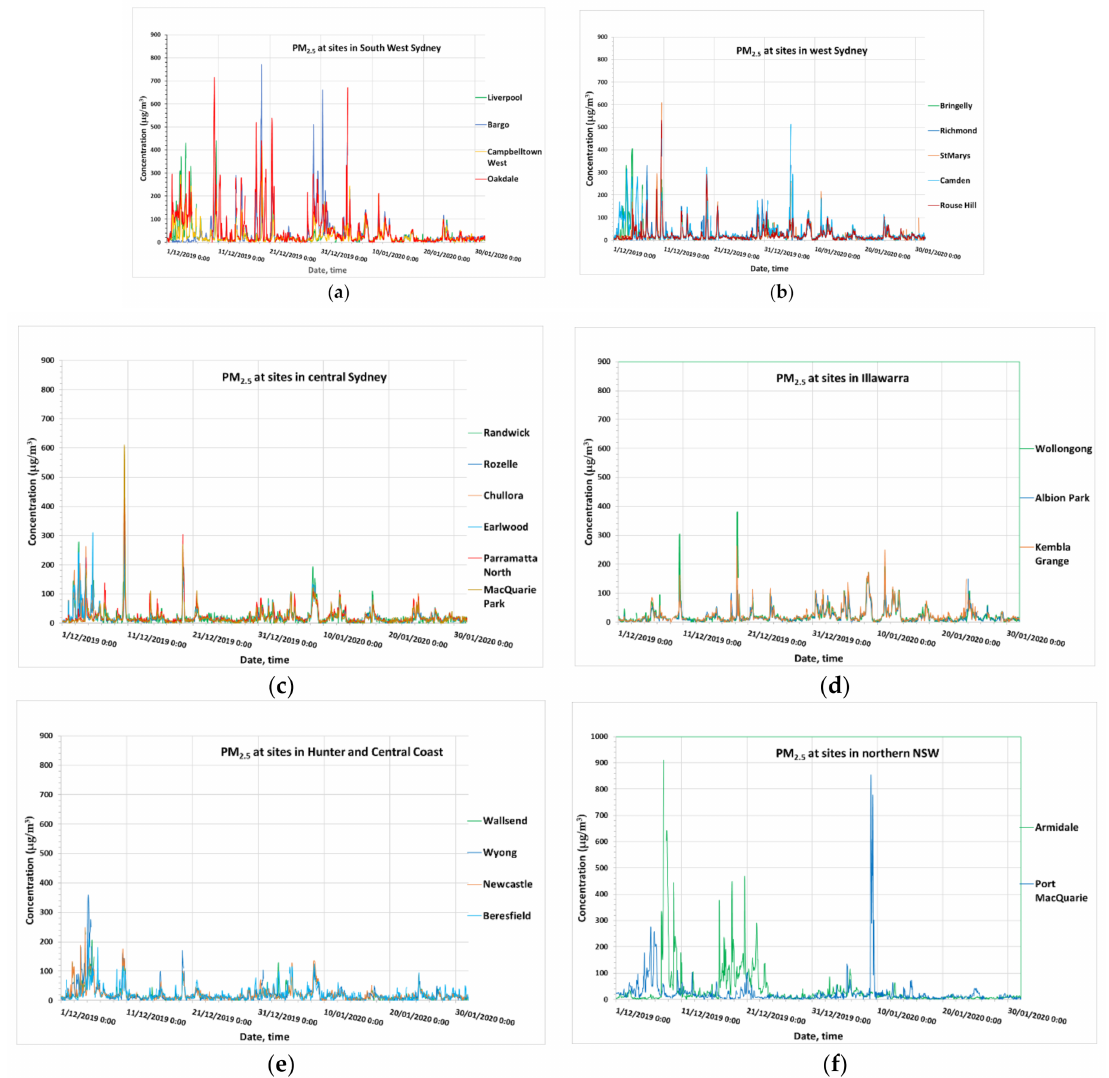
Figure 9. PM 2.5 concentration at sites in South West Sydney ( a ), west Sydney ( b ), central Sydney ( c ), Illawarra ( d ), Hunter ( e ) and northern NSW ( f ) from 1 December 2019 to 31 January